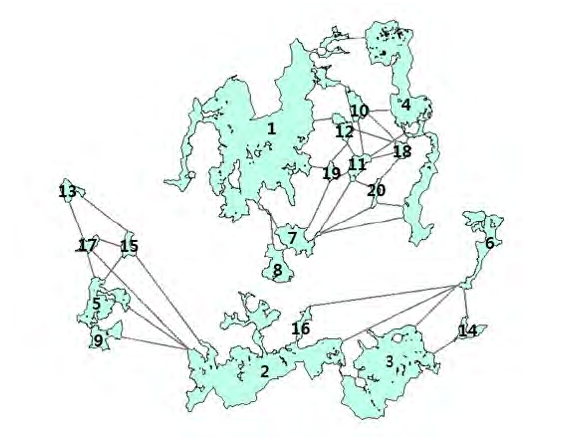
Figure 4. The extracted 20 Hubs and 42 links within Seoul.